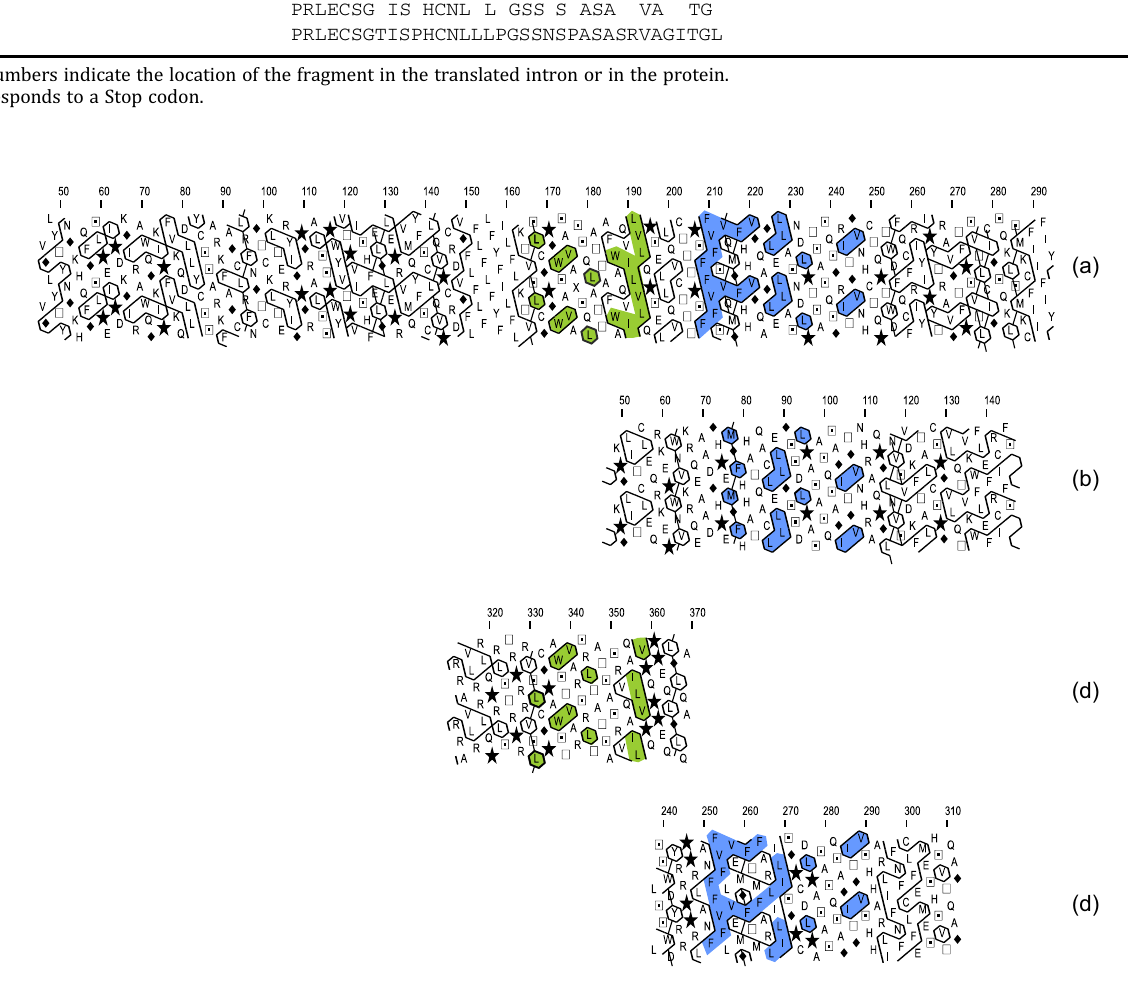
Figure 1. Hydrophobic cluster analysis of (a) human lysozyme intron 1, 5 ′ 3 ′ frame 1 (only amino acids 50 – 300 are visualized); (b) zinc fi nger protein: residues 76 – 114 correspond to residues 210 – 248 of the intron ( E = 6 e-08; identity: 76%); (c) human thromboxane A2 receptor: residues 328 – 368 correspond to residues 160 – 200 in the intron ( E = 7 e-06; identity: 69%); (d) human neuronal thread pro- tein: residues 252 – 319 correspond to residues 210 – 277 of the intron ( E = 0.042; identity: